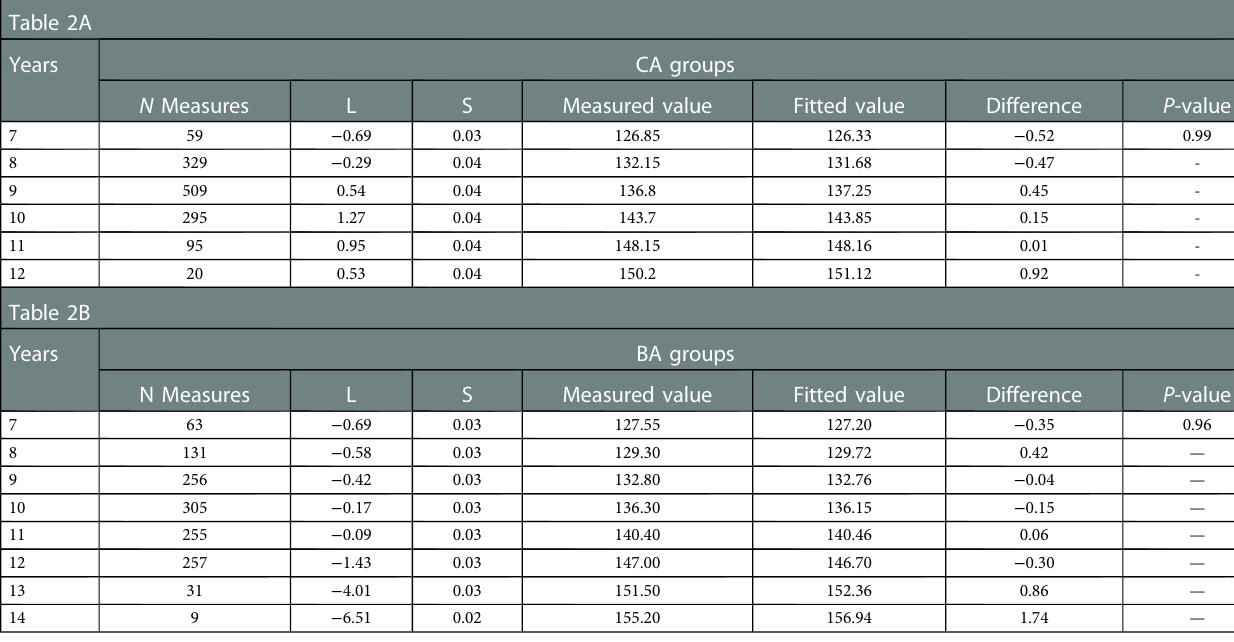
TABLE 2 Comparison between the P50th height (cm) of fi tted values and measured values. Table 2A